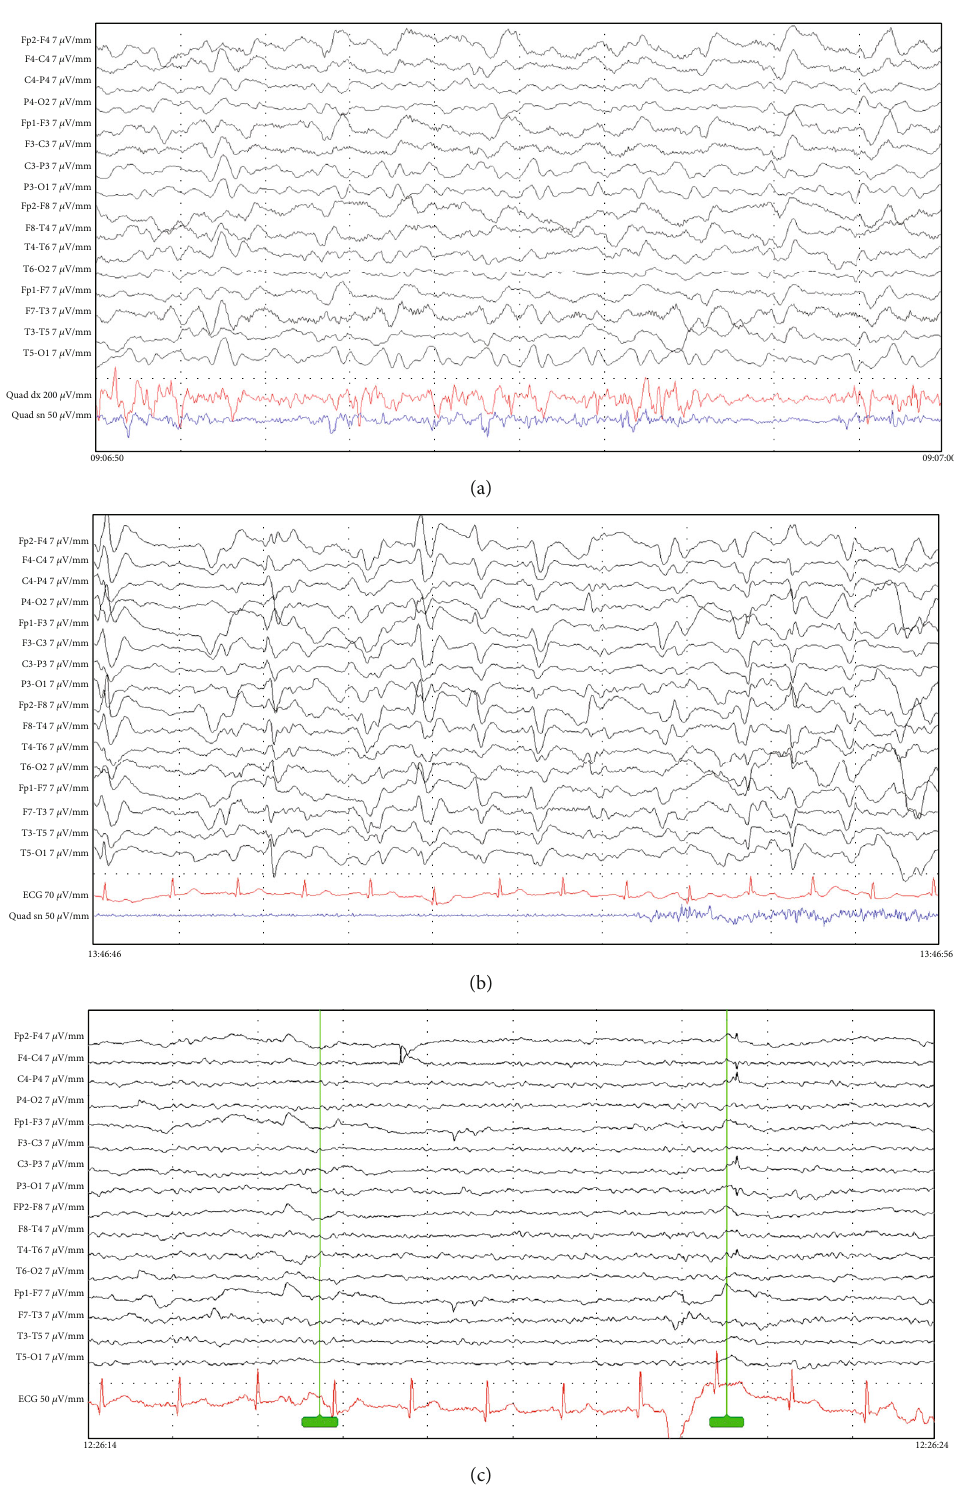
Figure 1: Serial EEG recordings. (a) First day after symptoms onset: presence of abundant and high sharply contoured bilateral waves in the absence of interictal epileptiform waves or discharges. There were no correlations between lower limb motor manifestations and EEG changes. The topography of the background activity was still partially preserved, although a slight slowing was observed. (b) The EEG pattern showed the presence of abundant triphasic waves with severe generalised slowing, suggesting the presence of encephalopathy. The topography of the background activity was no longer detected. (c) EEG, performed about 48 hours after the second recording, showed complete regression of the triphasic waves and restoration of the topography of the background activity, which had only slight